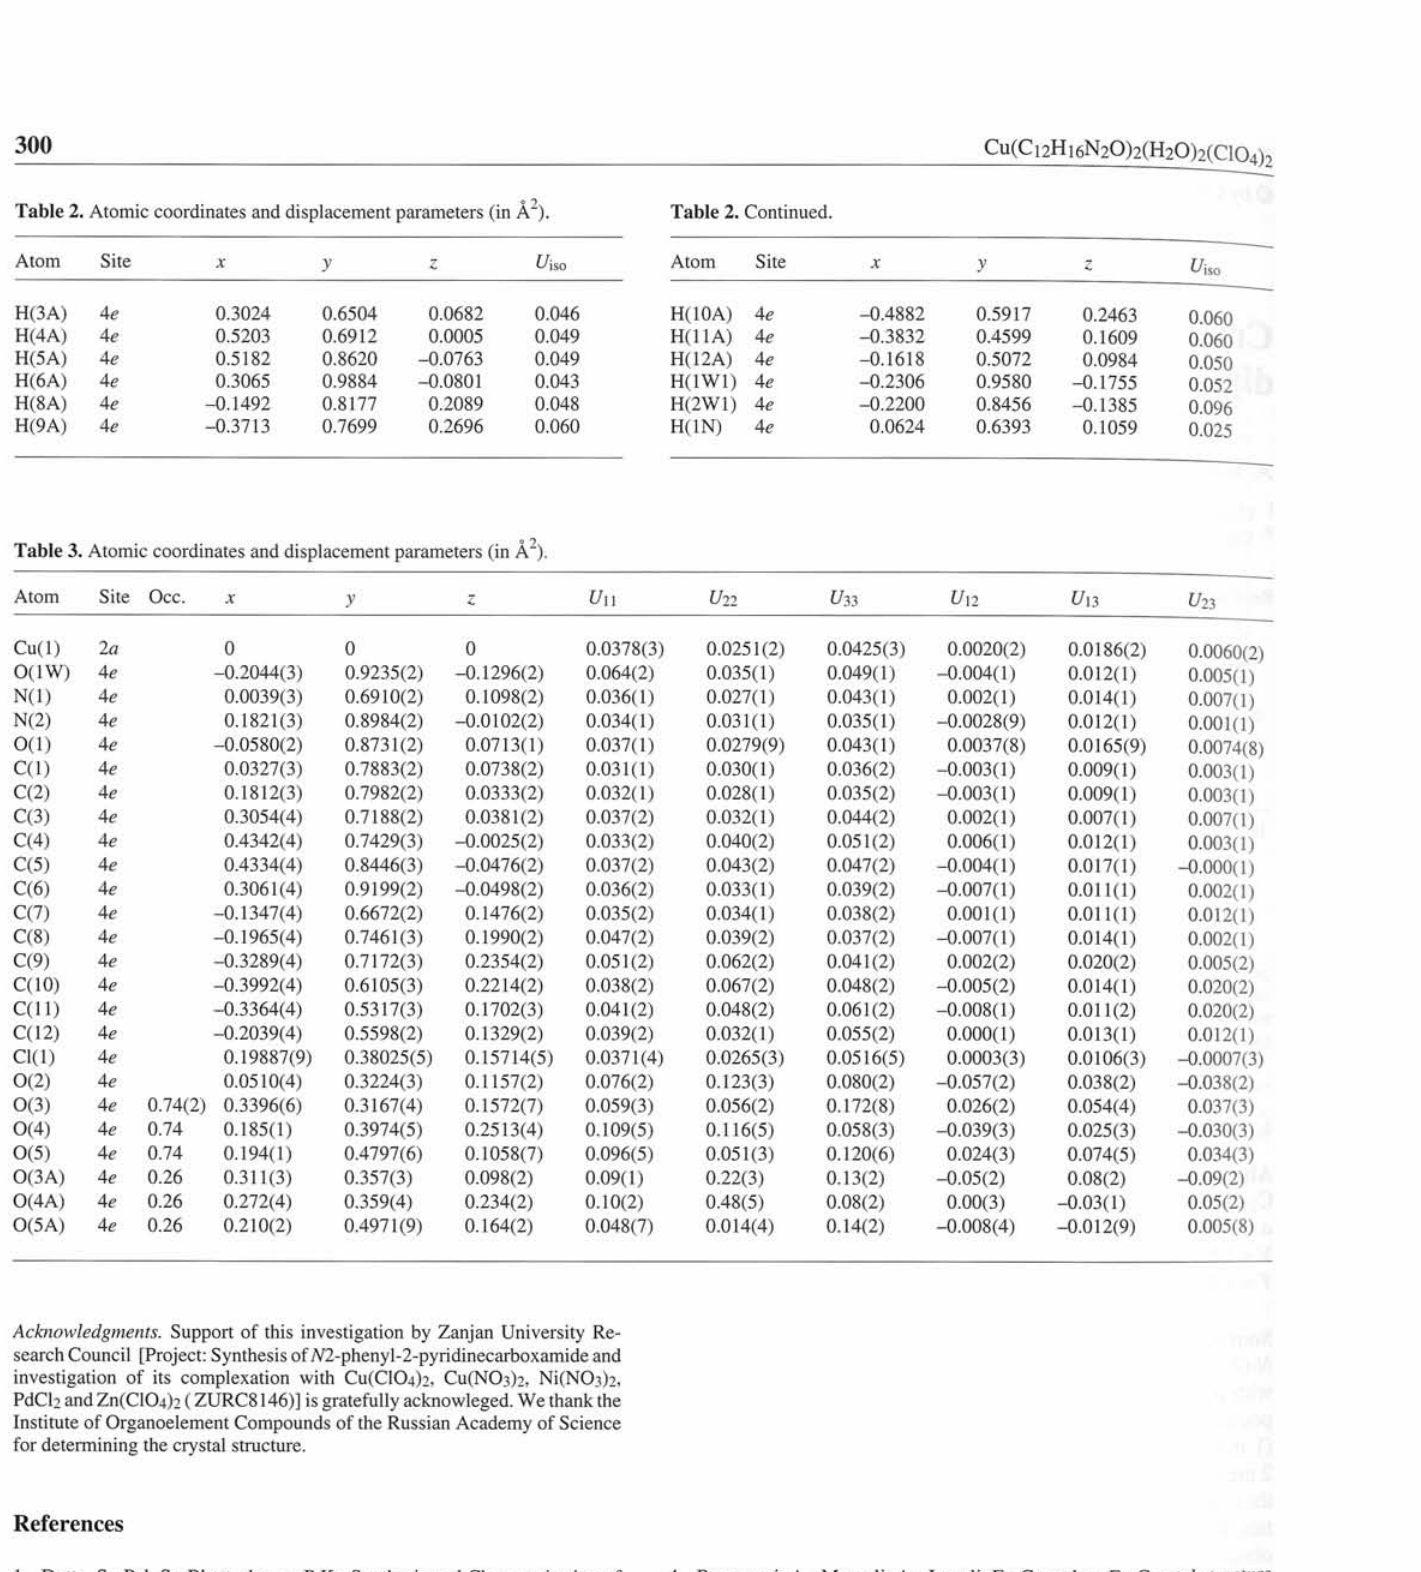
Table 2. Atomic coordinates and displacement parameters (in Â 2 ).